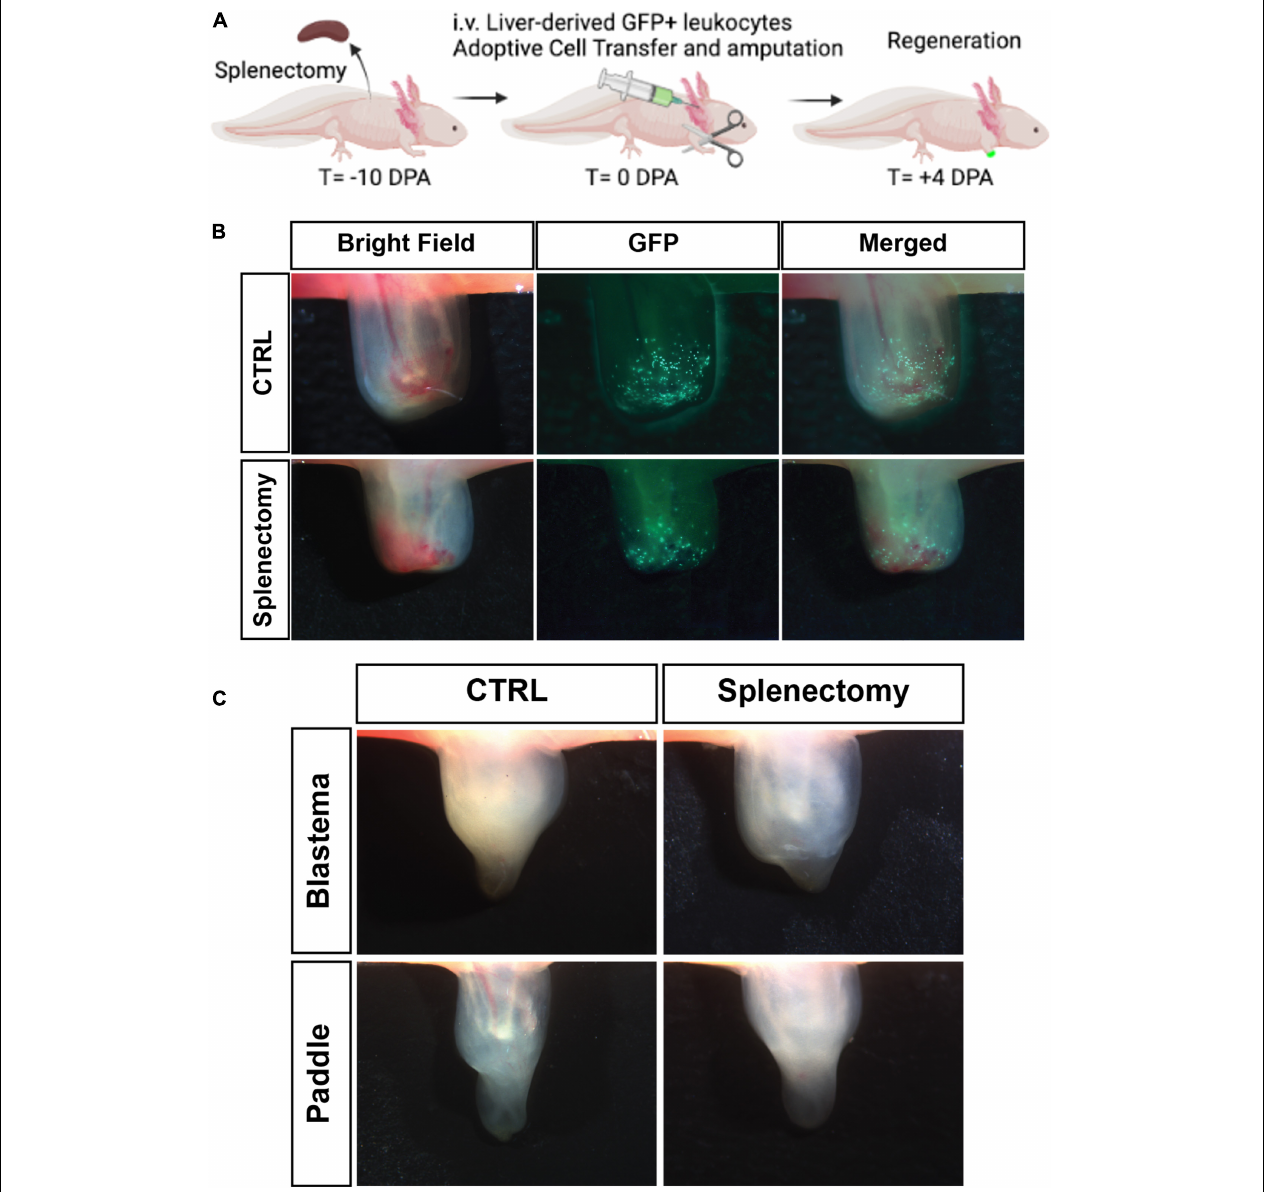
FIGURE 7 | The spleen is not required for liver-derived myeloid cell trafficking to the limb or for limb outgrowth. (A) Experimental timeline to study cellular contributions from the liver following splenectomy. (B) Live imaging of 4 dpa limb. GFP cells in the limb following 5 × 10 5 GFP liver cell transplant in non-splenectomized control cohort (Top row). GFP cells in the limb following 5 × 10 5 GFP liver transplant in splenectomized control cohort (Bottom row). ( N = 4 per group) (C) Live image of regenerating limbs with spleen (pictured left) and without spleen following splenectomy (pictured right). Critical regeneration stages shown. All animals regenerated their limbs in both groups. N = 8 animals per experimental